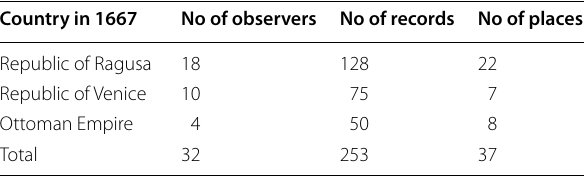
Table 2 Observers, records and places, according to their country of origin in